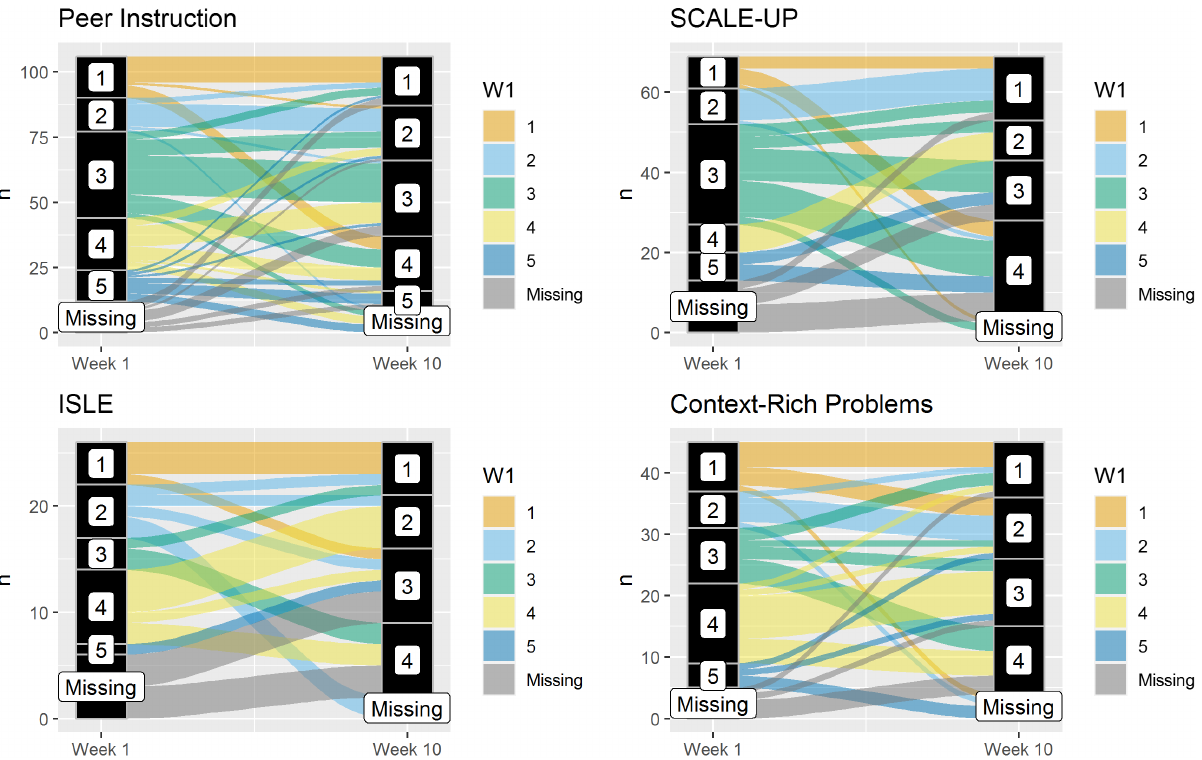
FIG. 7. Each diagram shows students ’ week 1 CONCOR block assignment in the first column, and their week 10 assignment in the second column. Colors match the original block assignment to help with visually following the flow. The missing label indicates students who were not present (either as survey takers or named) in that week ’ s